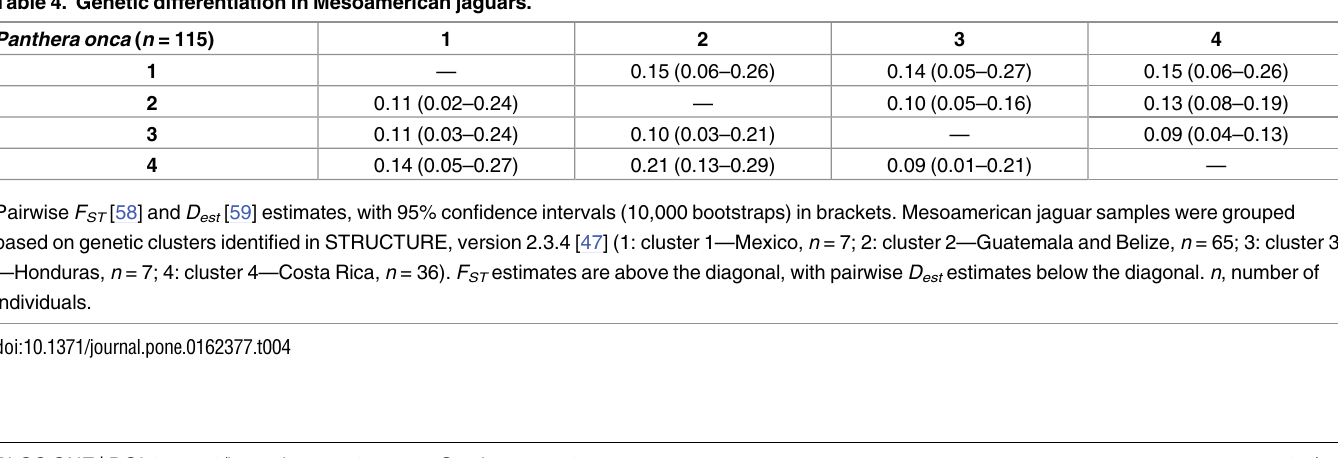
Table 4. Genetic differentiation in Mesoamerican jaguars. Panthera onca ( n = 115)